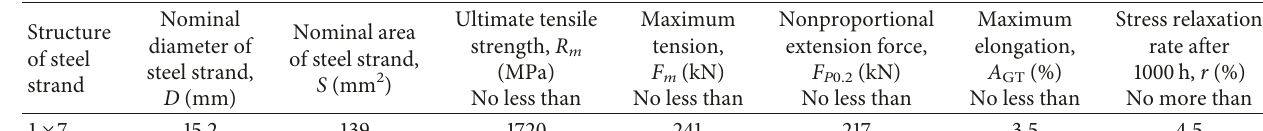
Table 1: Parameters of the steel strand.